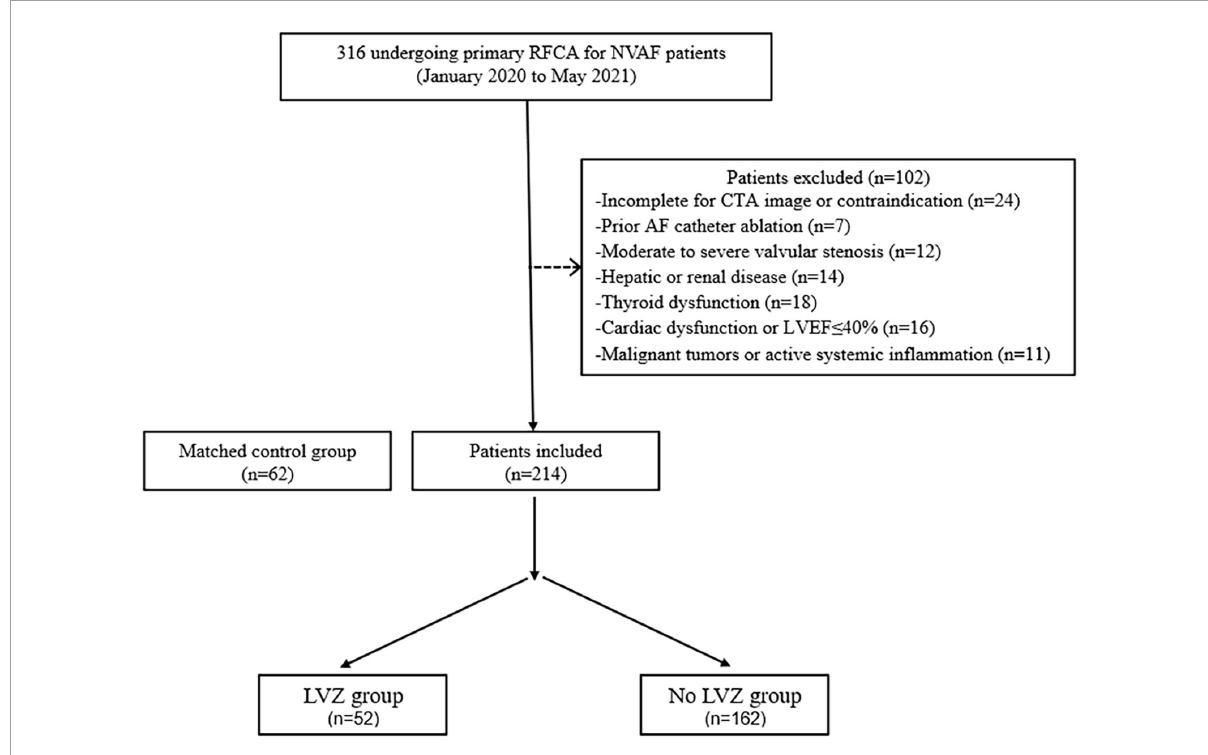
FIGURE1 Flow chart detailing the inclusion and exclusion